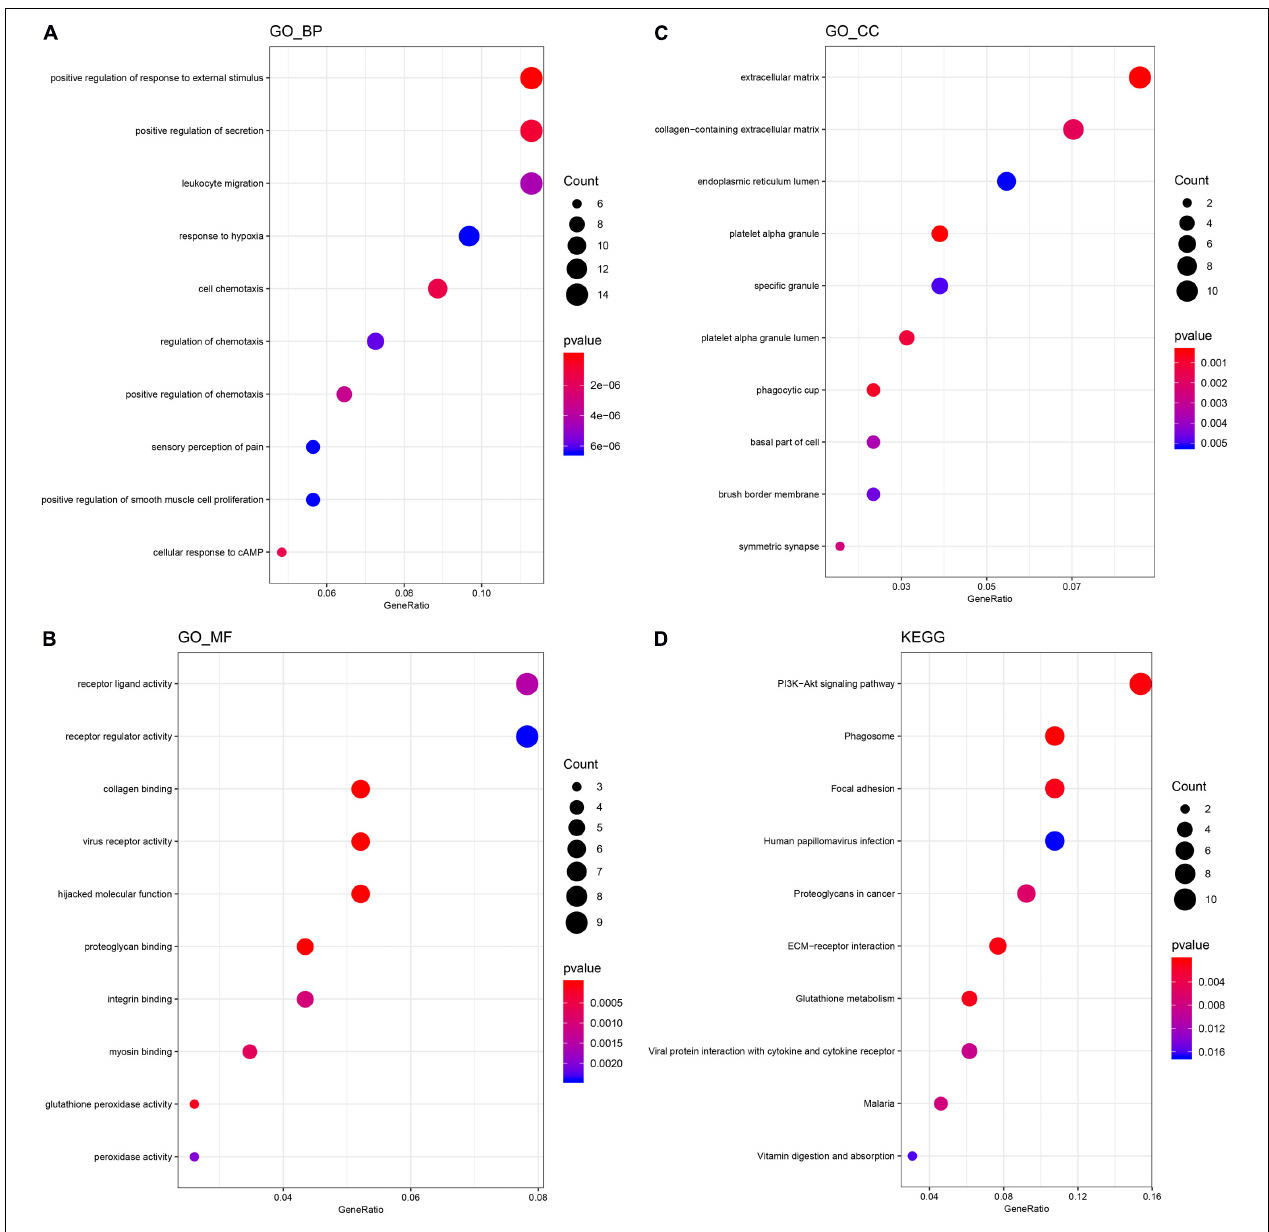
FIGURE 2 | GO and KEGG analysis of differentially expressed mRNA. (A) The top 10 GO terms of the biological process domain. (B) The top 10 GO terms of the molecular function domain. (C) The top 10 GO terms of the cellular component domain. (D) The top 10 signaling pathways enriched by the KEGG